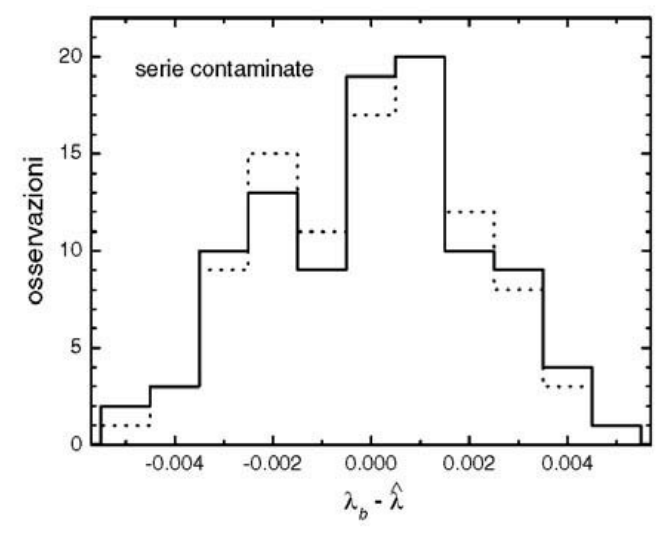
Figura 5 – Come in Fig. 4, ma con serie contaminate. Rapporto segnale/rumore =